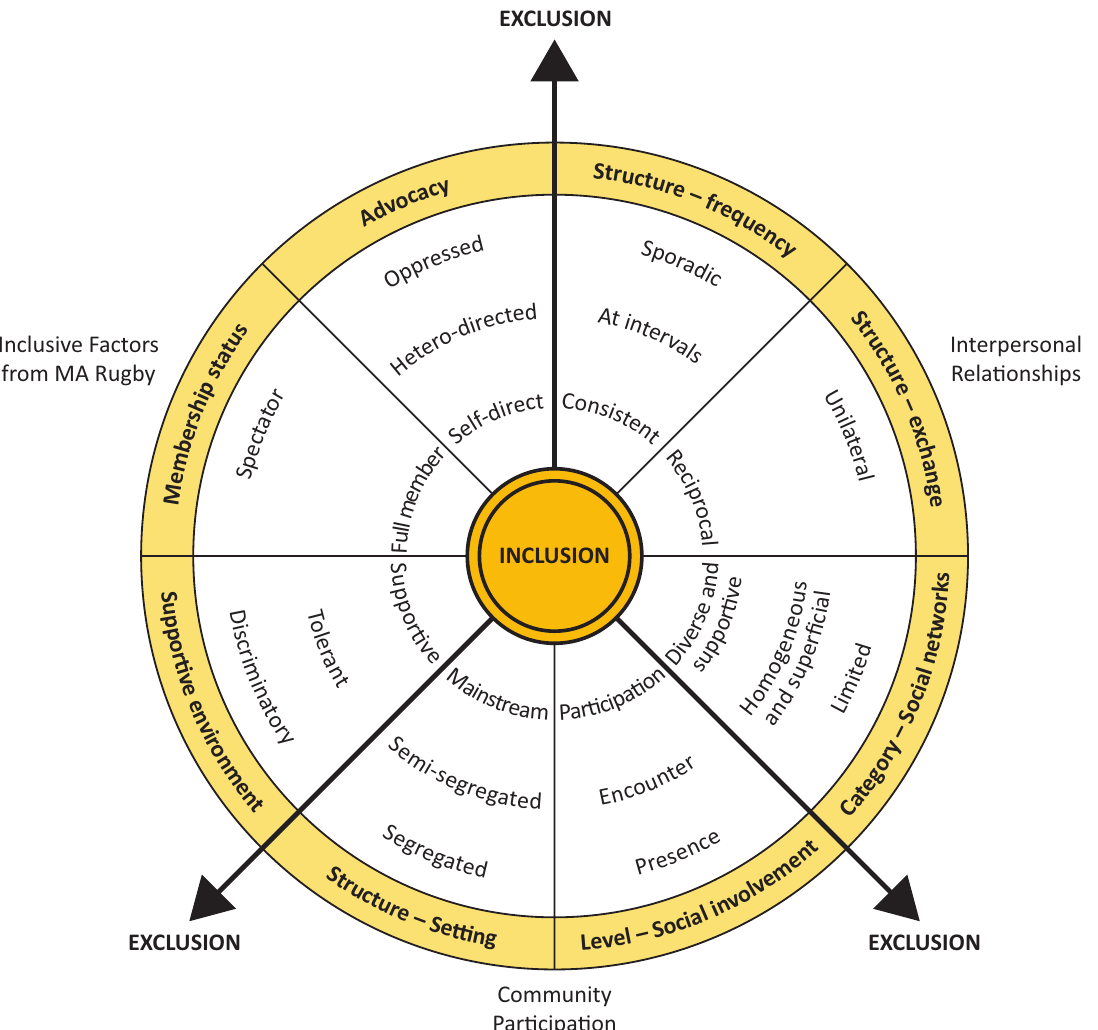
Figure 2. ‘Wheel of Inclusion’ incorporating key elements of Simplican et al.’s (2015) model of inclusion as well as expanding on the model in the context of MA